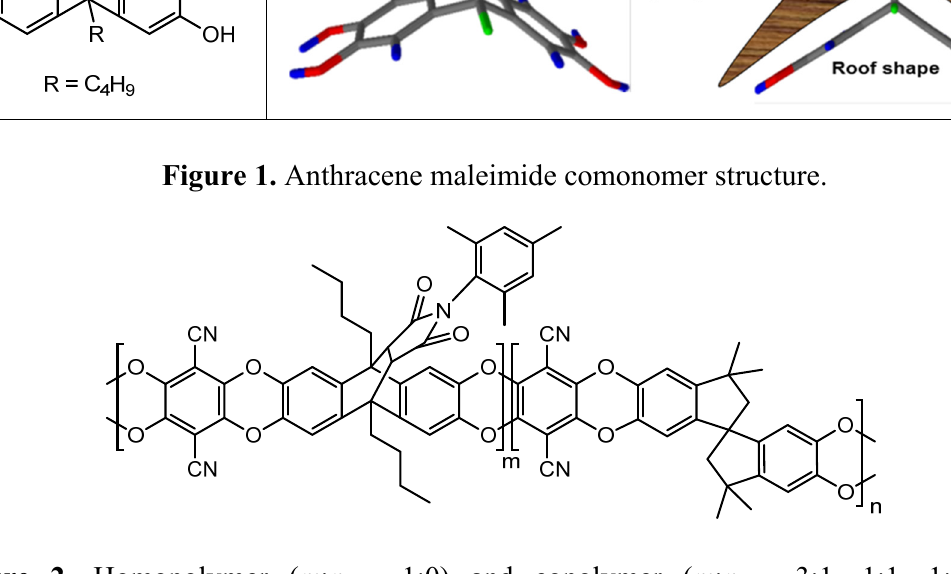
Figure 2. Homopolymer ( m : n = 1:0) and copolymer ( m : n = 3:1, 1:1, 1:2.3) of comonomer